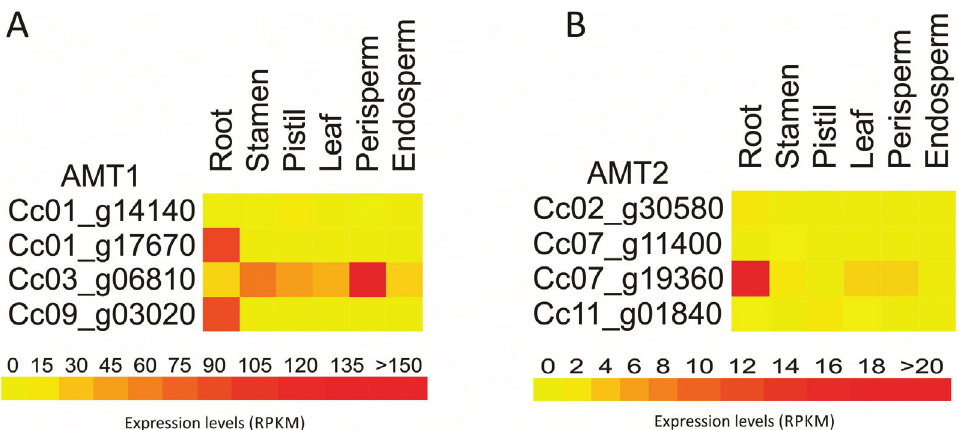
Figure3 - Insilico expressionprofileof C.canephoraAMT1 (A)and AMT2 (B)genefamilies.RNAseqdatafromroots,stamen,pistil,leaves,perisperm, and endosperm were obtained from Coffee Genome Hub